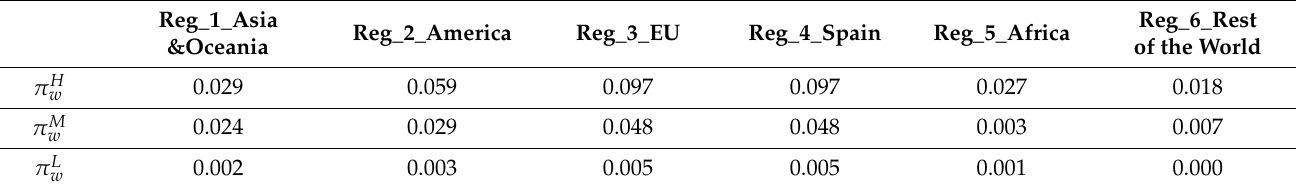
Table 4. Water prices of the 3 qualities (Q) by